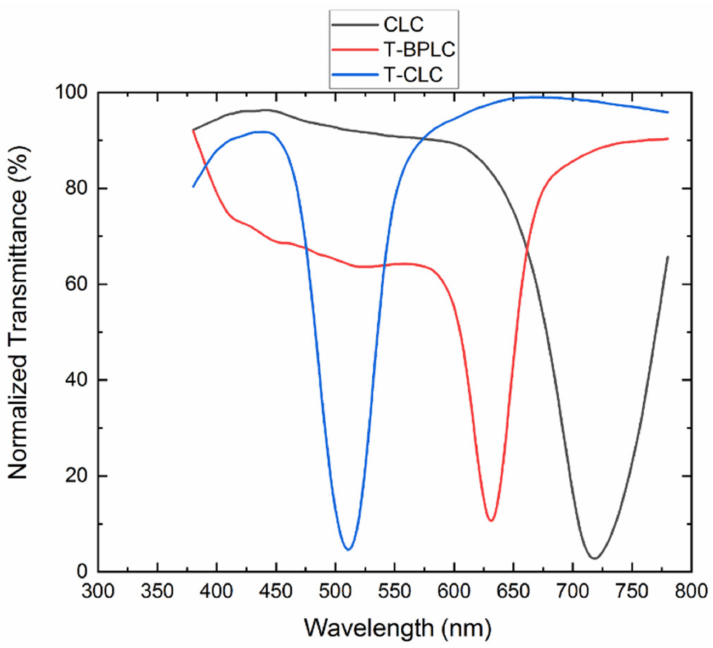
Figure 7. Transmittance spectra of T-CLC, T-BPLC and